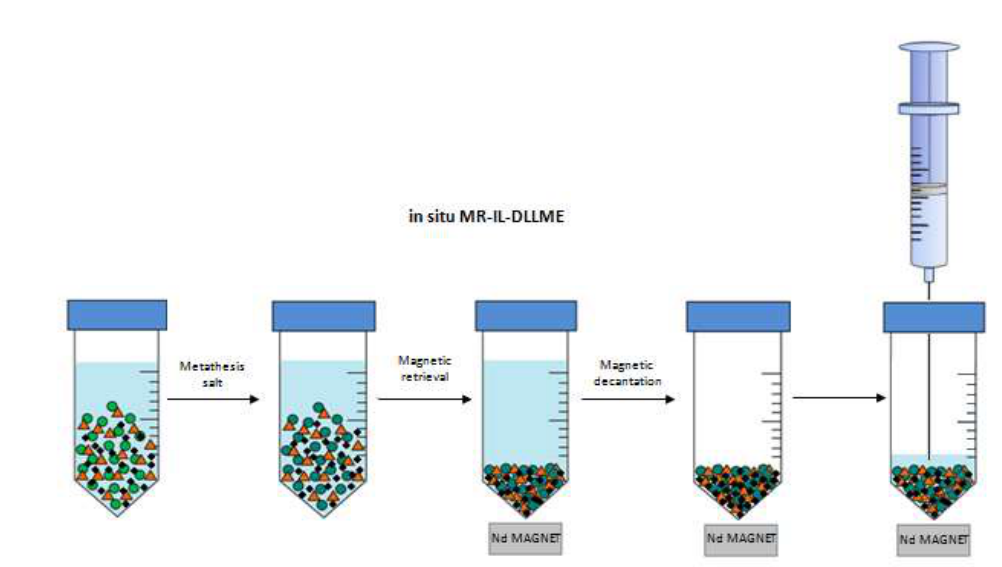
Figure 3. Schematic representation of the MR in situ IL-DLLME extraction steps.